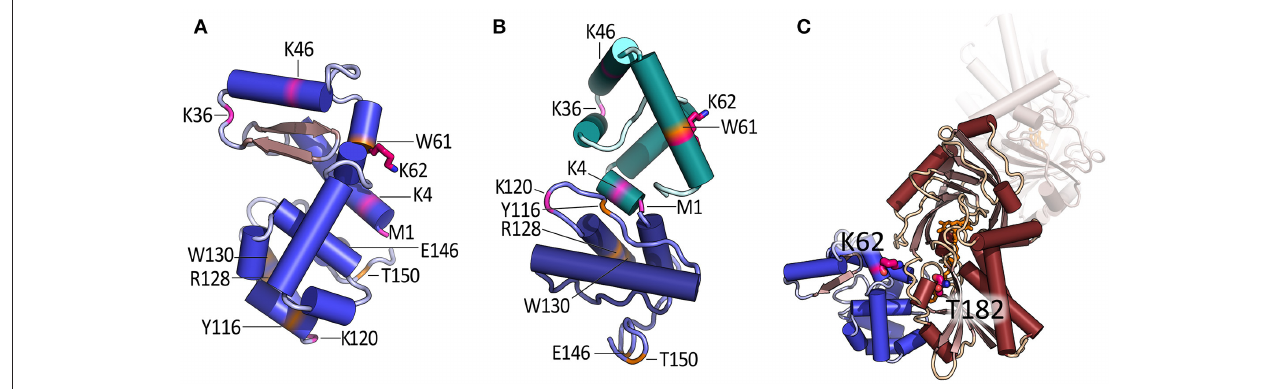
FIGURE 3 | Model of the tertiary structure of pLG72 and proposed mode of interaction with hDAAO. (A) Homology 3D model of pLG72 produced by I-TASSER server, i.e., pLG72-VA (Birolo et al., 2016) and (B) model produced by hybrid ab initio approach (Kato and Fukui, 2017). Proteolytic sites are shown in orange, residues modified by BS 3 cross-linking reagent are shown in pink, and cross-linked K62 residue is shown in purple. (C) Model of hDAAO–pLG72 complex as predicted by ZDOCK server; pLG72 model is in blue, hDAAO dimer in brown, and cross-linked K62 (pLG72), and T182 (hDAAO) are shown in purple (Birolo et al., 2016). For details see Figure 1